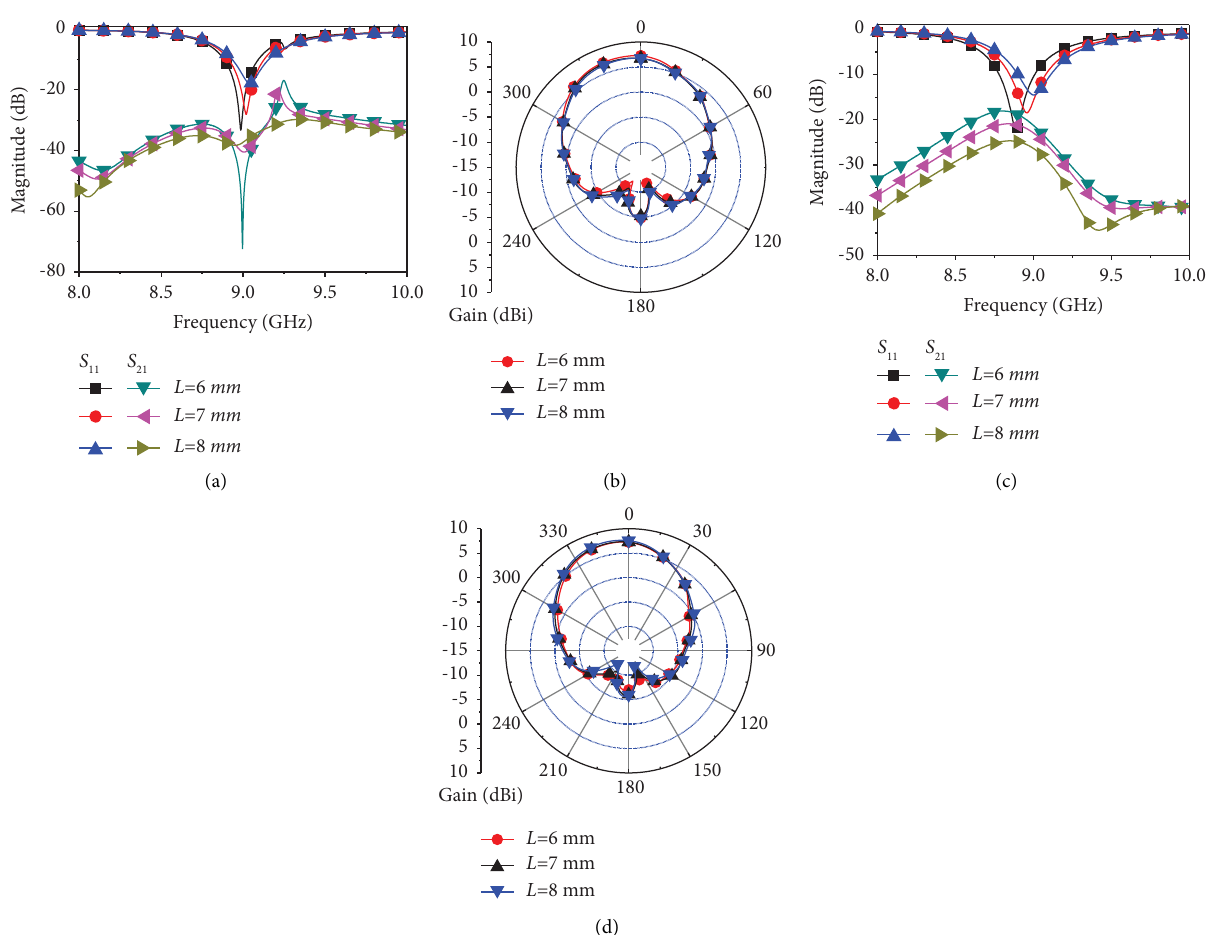
Figure 8: Comparison results of the predicted microstrip antenna arrays. (a) S parameters (with WCSRRs). (b) Radiation patterns (with WCSRRs). (c) S parameters (without WCSRRs). (d) Radiation patterns (without WCSRRs).